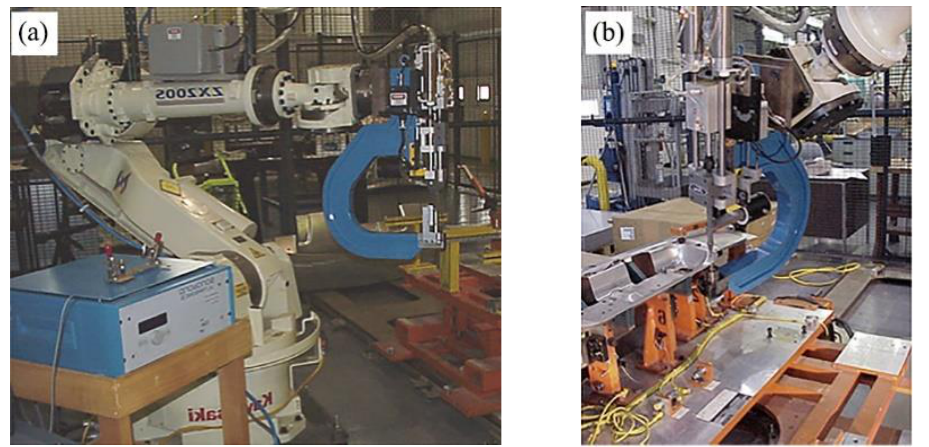
Figure 3. ( a ) USW robotic; ( b ) automotive closure panel [28].